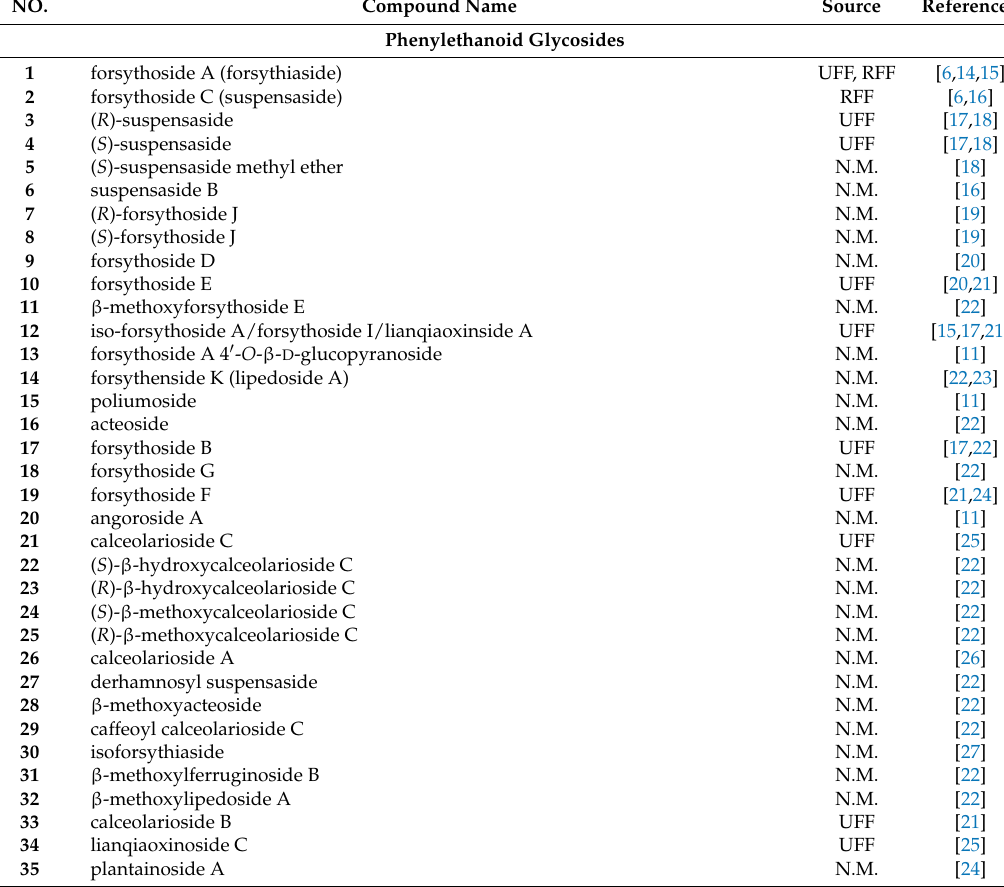
Table 1. Compounds identified from Forsythiae